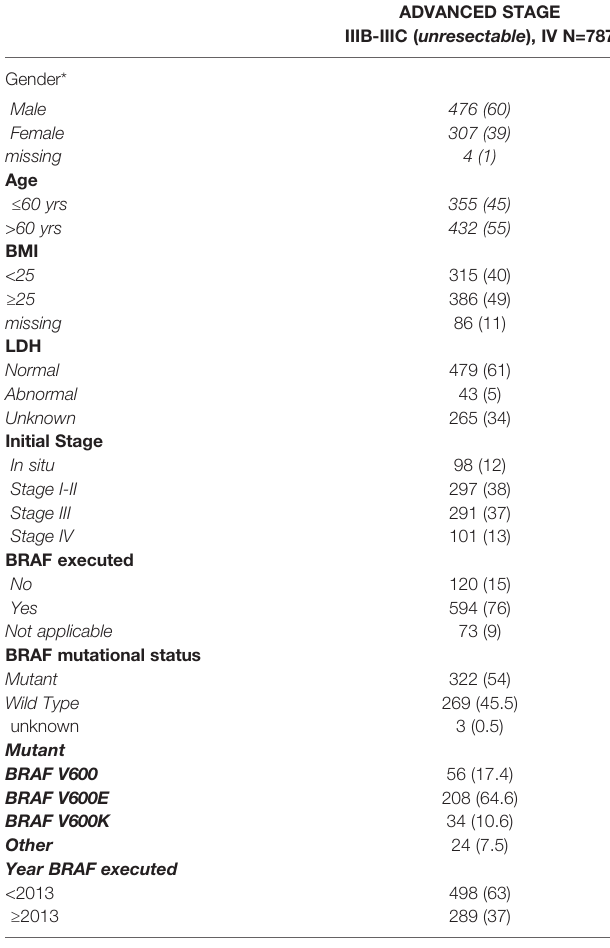
TABLE 1 | Tumor characteristics for Advanced Stage (IIIB-IIIC unresectable,